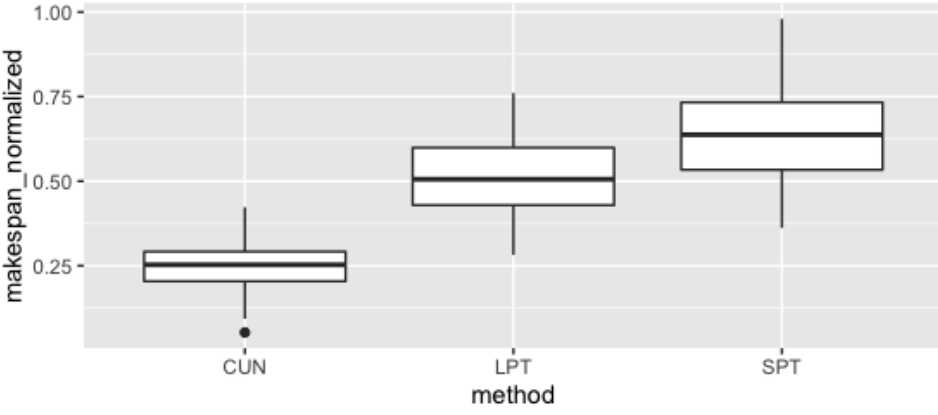
Figure 7. Boxplot of the normalized makespan of the three methods.